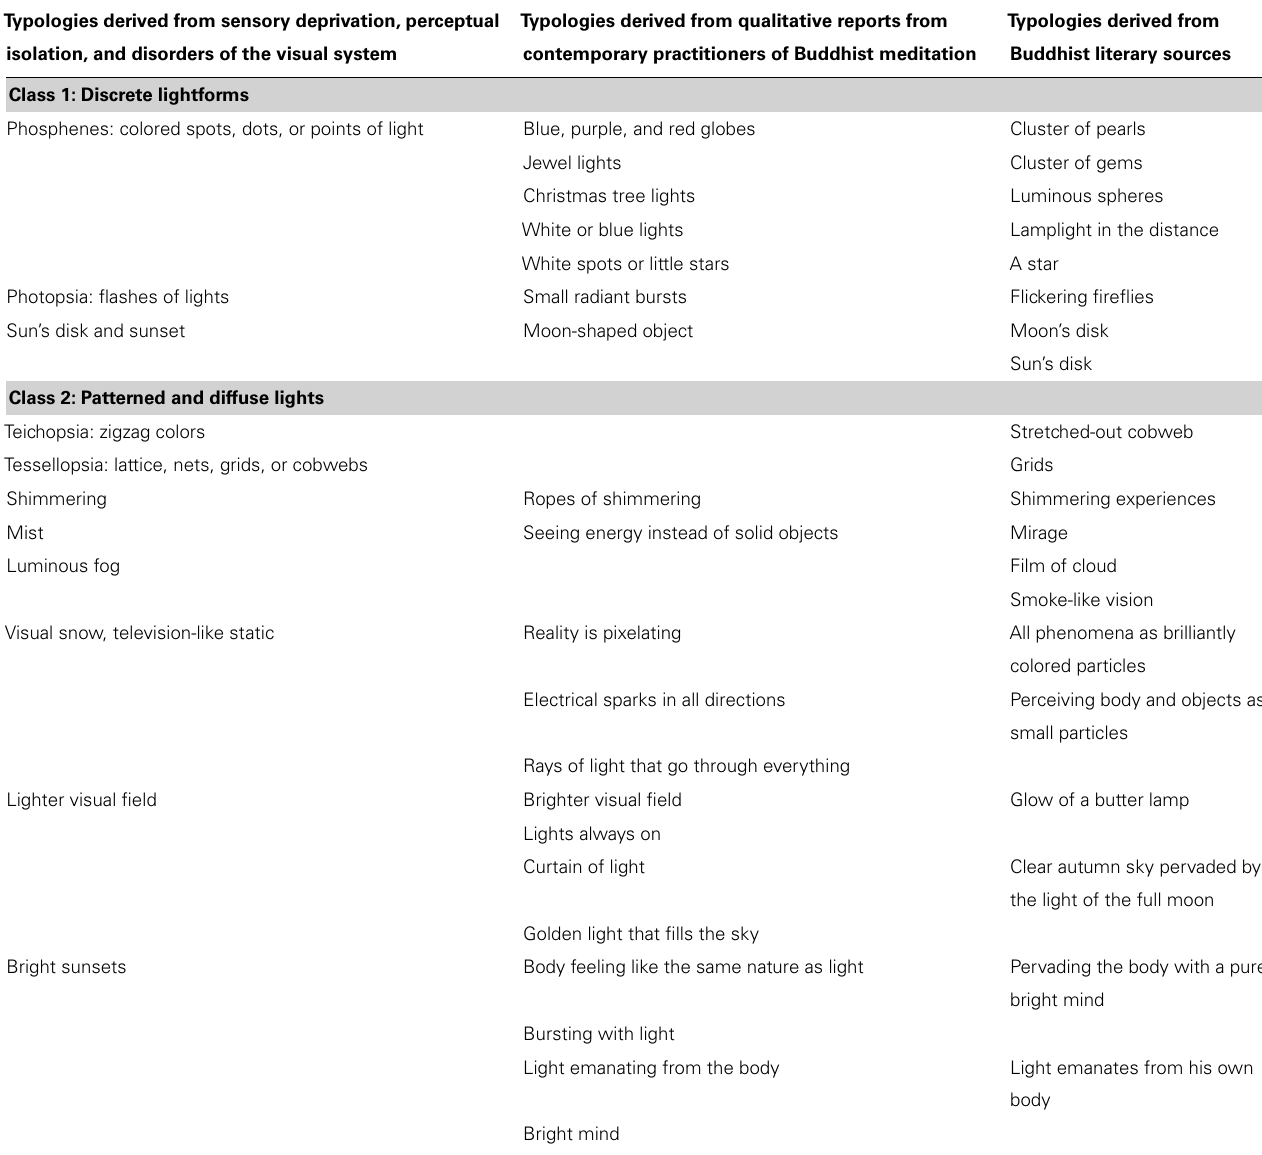
Table 2 | Comparative typology of visual hallucinations and meditation-related light experiences. Typologies derived from sensory deprivation, perceptual Typologies derived from qualitative reports isolation, and disorders of the visual system